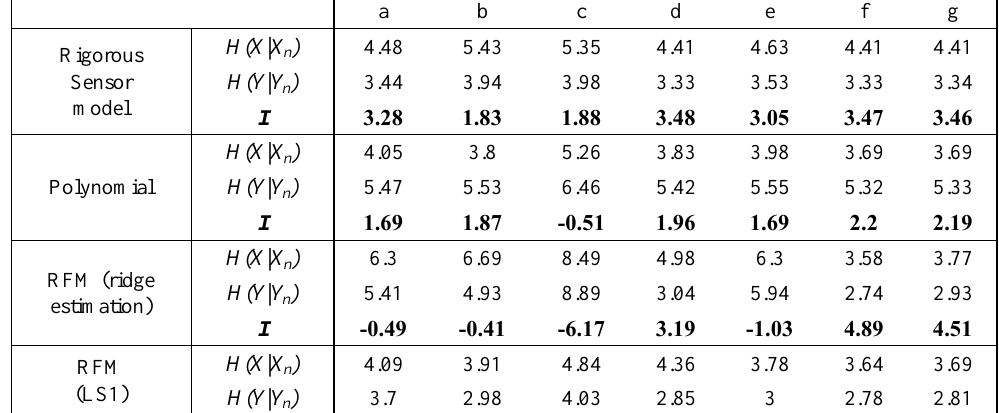
Table 2. The entropy after geometric correction and the amount of information of four approaches in seven situations (Unit: Hart) a Rigorous